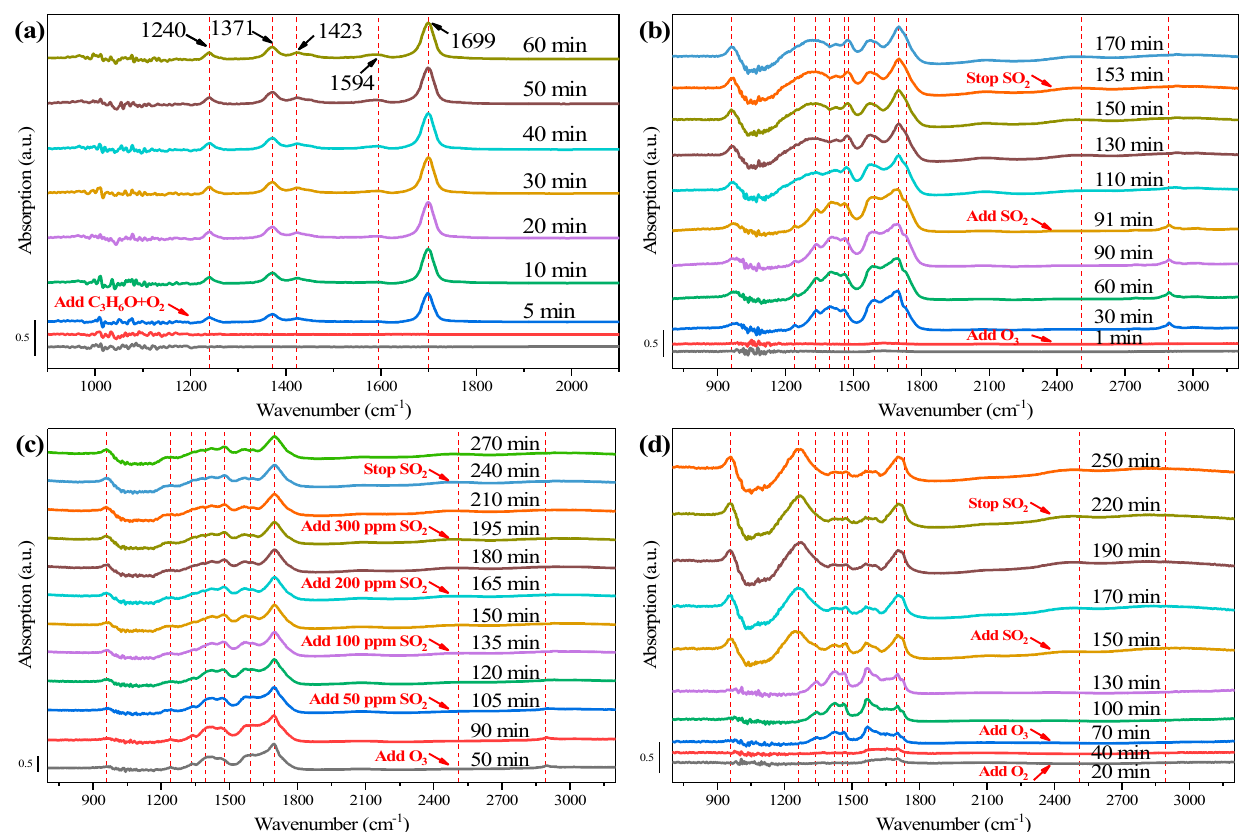
Figure 7. In-situ DRIFTS measurement over Cr1.5% catalysts of: ( a ) C 3 H 6 O + O 2 ; ( b ) C 3 H 6 O + O 2 /O 3 + SO 2 ; ( c ) C 3 H 6 O + O 2 /O 3 + (50~300 ppm) SO 2 ; ( d ) C 3 H 6 O + O 2 /O 3 + SO 2 , with water adsorbed.